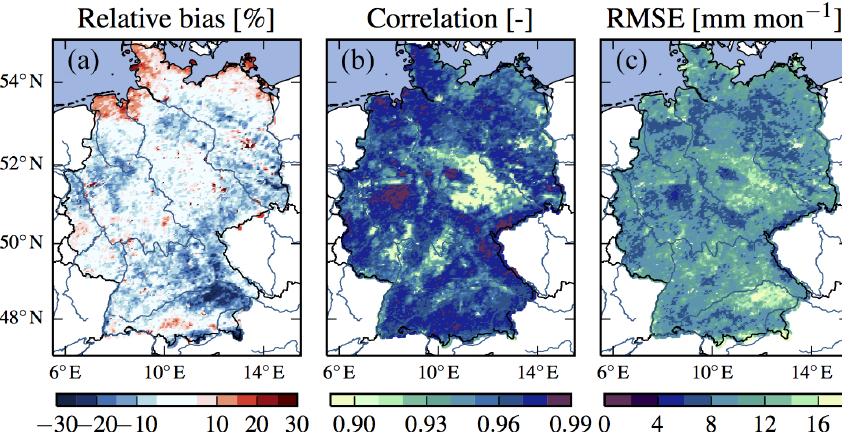
Figure 7. Comparison of monthly estimates of evapotranspiration from mHM and MODIS in the period 2001–2010. The ensemble is repre- sented by the ensemble mean of 100 evapotranspiration estimates. The comparison is based on three metrics: (a) relative bias, (b) Pearson correlation coefficient, and (c) root mean squared error (RMSE). The respective units are given in brackets.